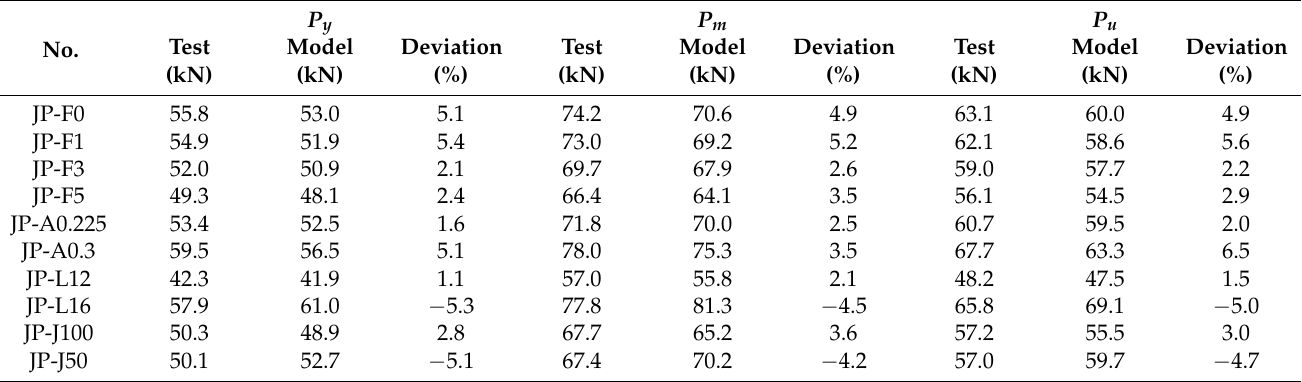
Table 7. Comparison of load test value and calculation